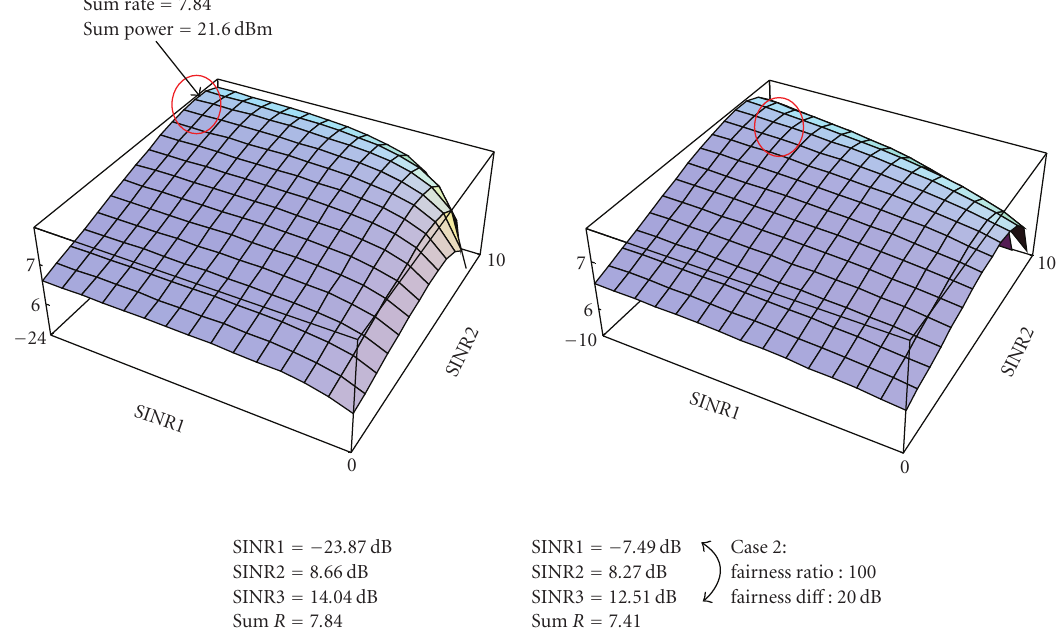
Sum power = 145 (mW); antennas 1 × 4